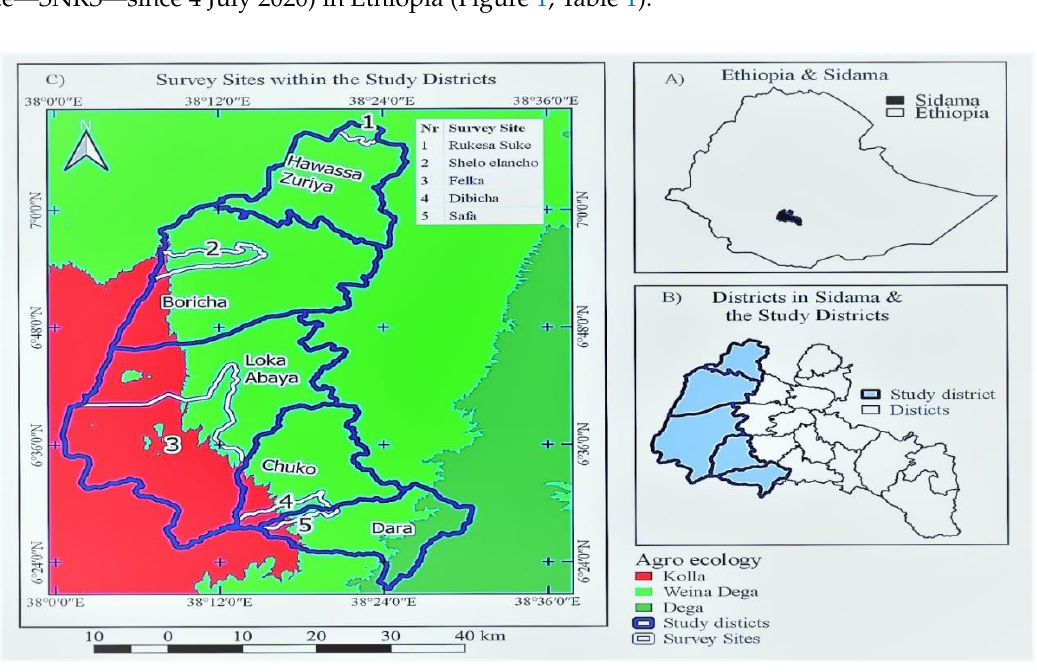
Figure 1. Map of the study area. Source: authors’ work. Table 1. Geophysical characteristics of the study